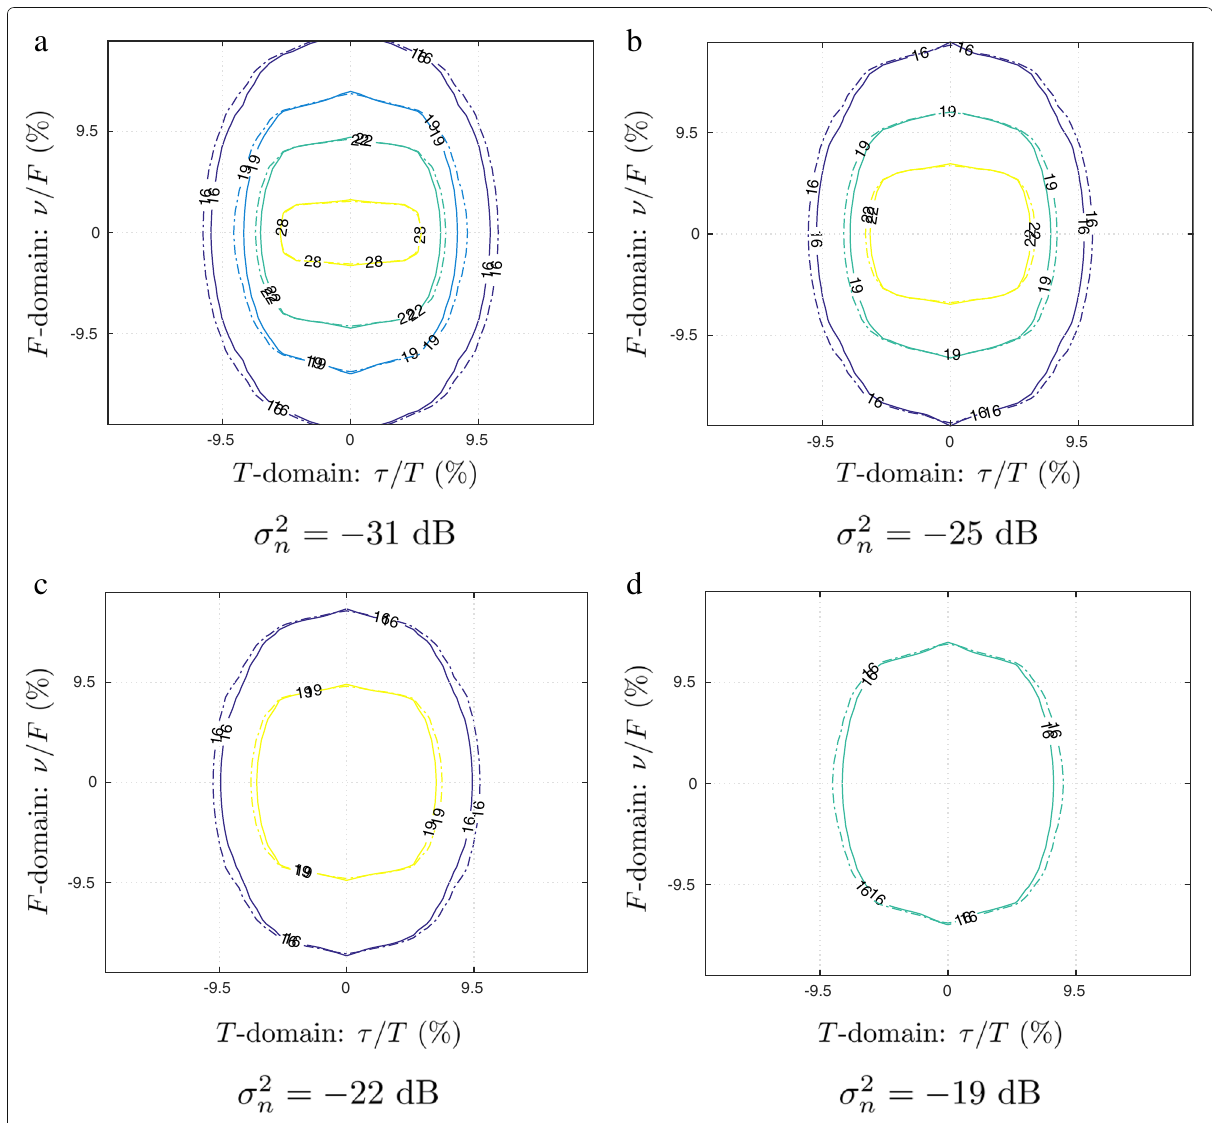
Table 5 Simulation parameters for extreme cases Parameters Values Number of subcarriers 128 Samples per symbol 160 Filter length 320 Convergence coefficient 10 − 4 Noise power (low) 0 Noise power (high) − 1dB Normalized maximum time delay in Fig. 13 10% Normalized maximum Doppler shift in Fig. 13 0 Normalized maximum time delay in Fig. 14 5% Normalized maximum Doppler shift in Fig. 14 ≈